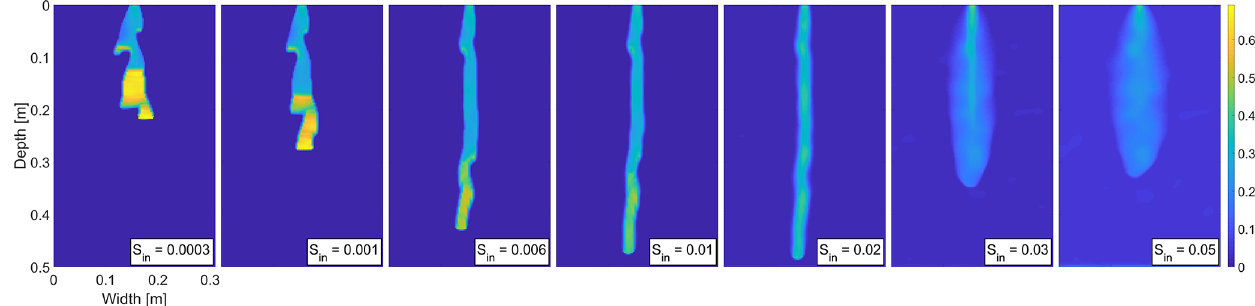
Figure A9. Snapshot of the saturation field at 25min for seven different values of the initial saturation for the distribution which satisfies κ max /κ min ≈ 3 . 50 (the distribution in Fig. A2h). Saturation values are color coded according to the color bar on the